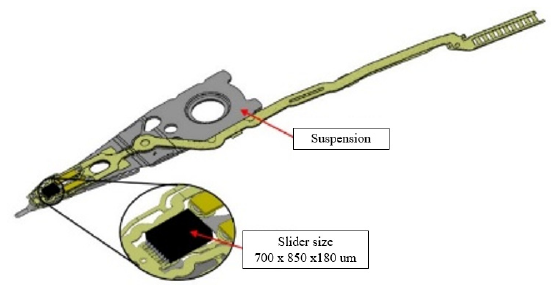
Figure 1. Head gimbal assembly (HGA) component.